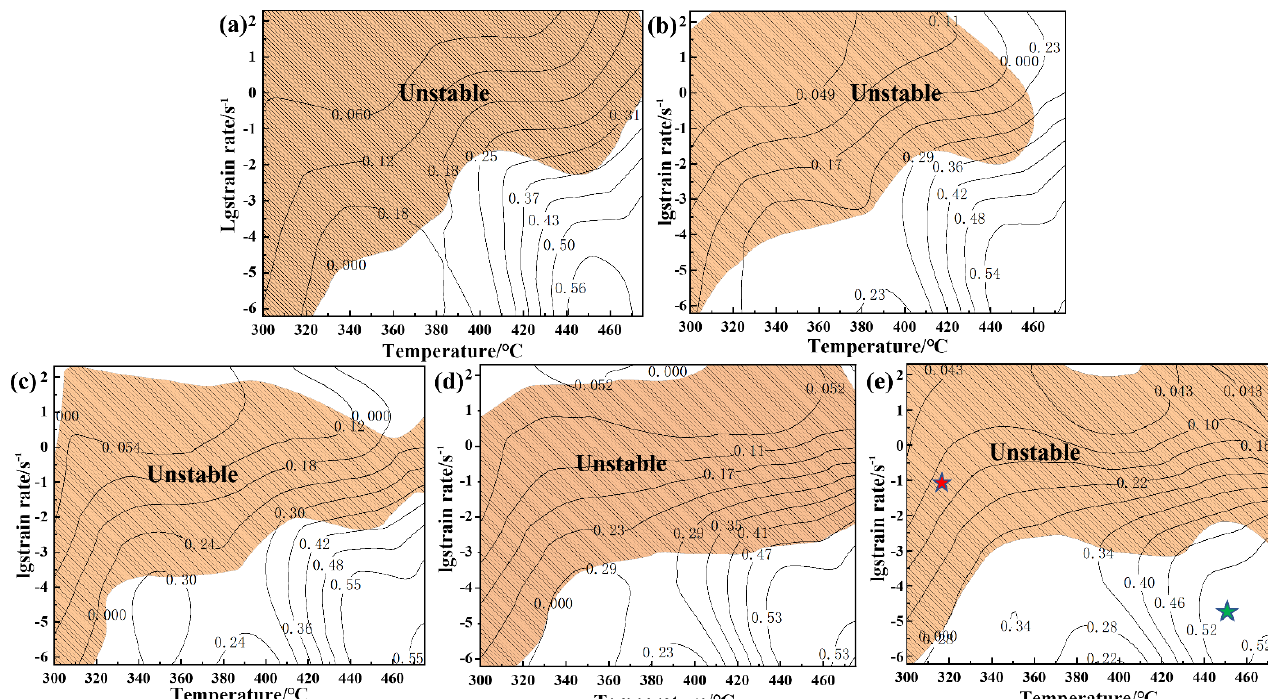
Figure 12. Hot processing map of Mg-8.7Gd-4.18Y-0.42Zr alloy at different strains: ( a ) 0.1, ( b ) 0.3, ( c ) 0.5, ( d ) 0.7, ( e ) 0.9.